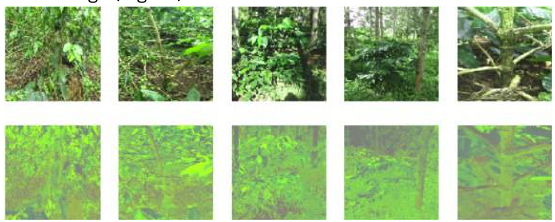
Figure 17. Reconstruction of Raw Images using Autoencoder